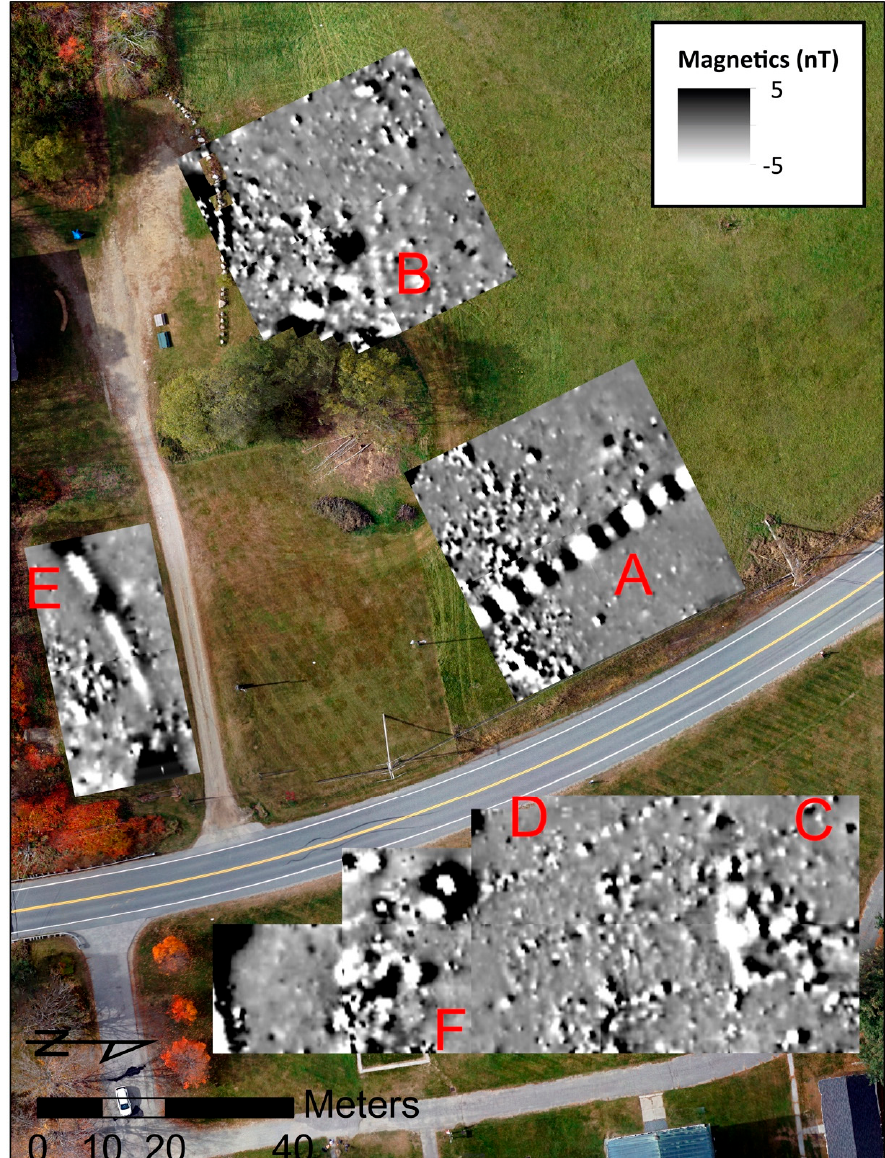
Figure 10. Magnetic Gradiometer data from the Enfield Shaker Village, recorded 18–19 October 2016.